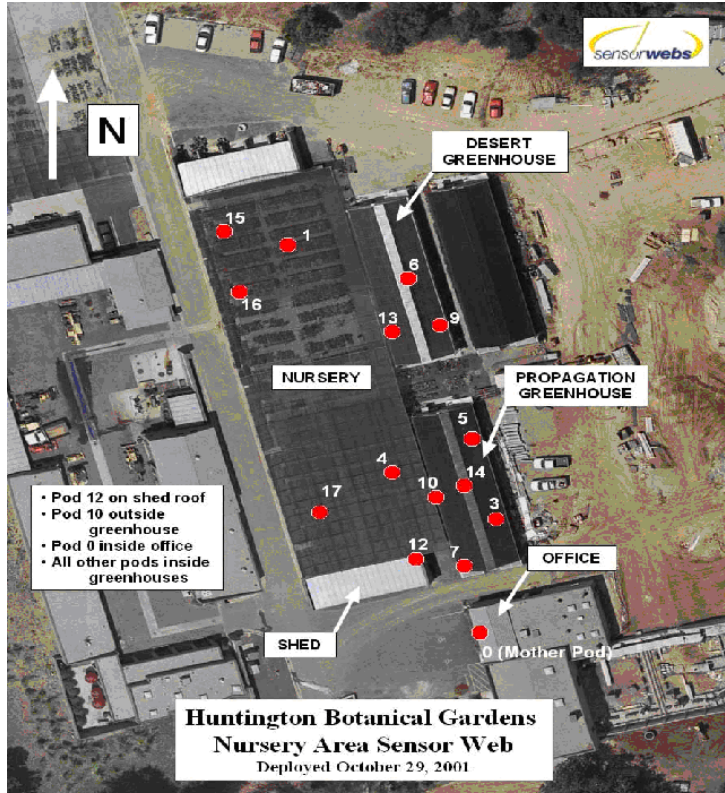
Figure 11. Map of Sensor Web 3 at the Huntington Garden. Note the size of the cars